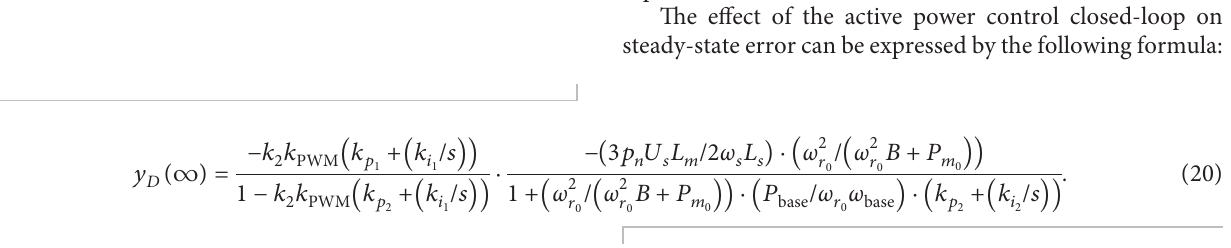
Figure 16: The change of the zero-pole diagram of the speed control closed-loop when the k